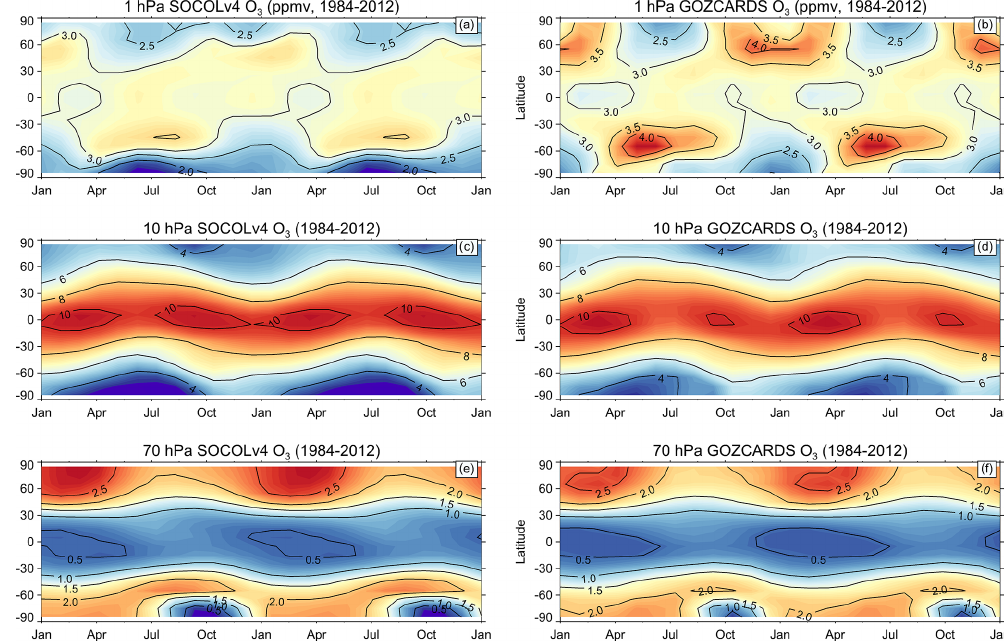
Figure 13. The 1, 10, and 70hPa ozone zonal mean seasonal cycles (ppmv). First column: SOCOLv4 data. Second column: GOZCARDS observational data. Two consecutive cycles are shown.